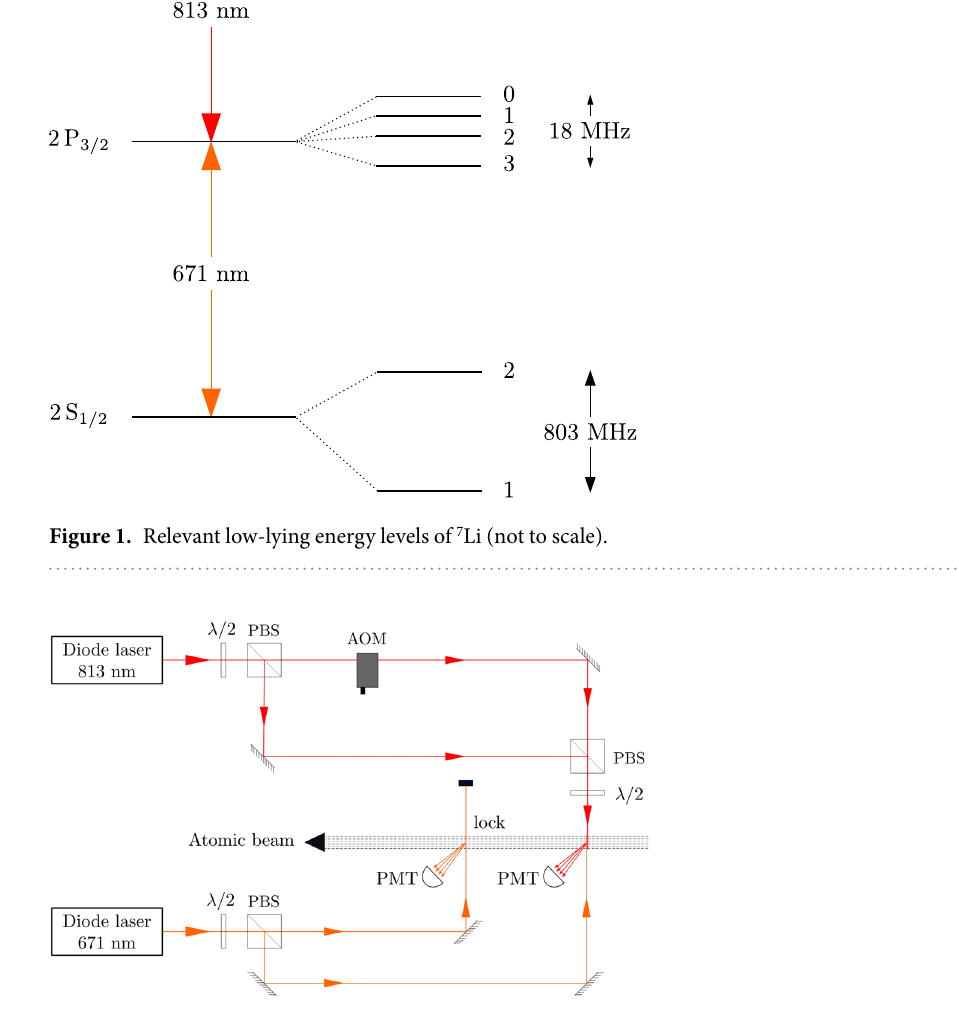
Figure 2. Experimental schematic. Figure key: λ /2 – halfwave retardation plate; PBS – polarizing beam splitter; AOM – acousto-optic modulator; PMT – photomultiplier